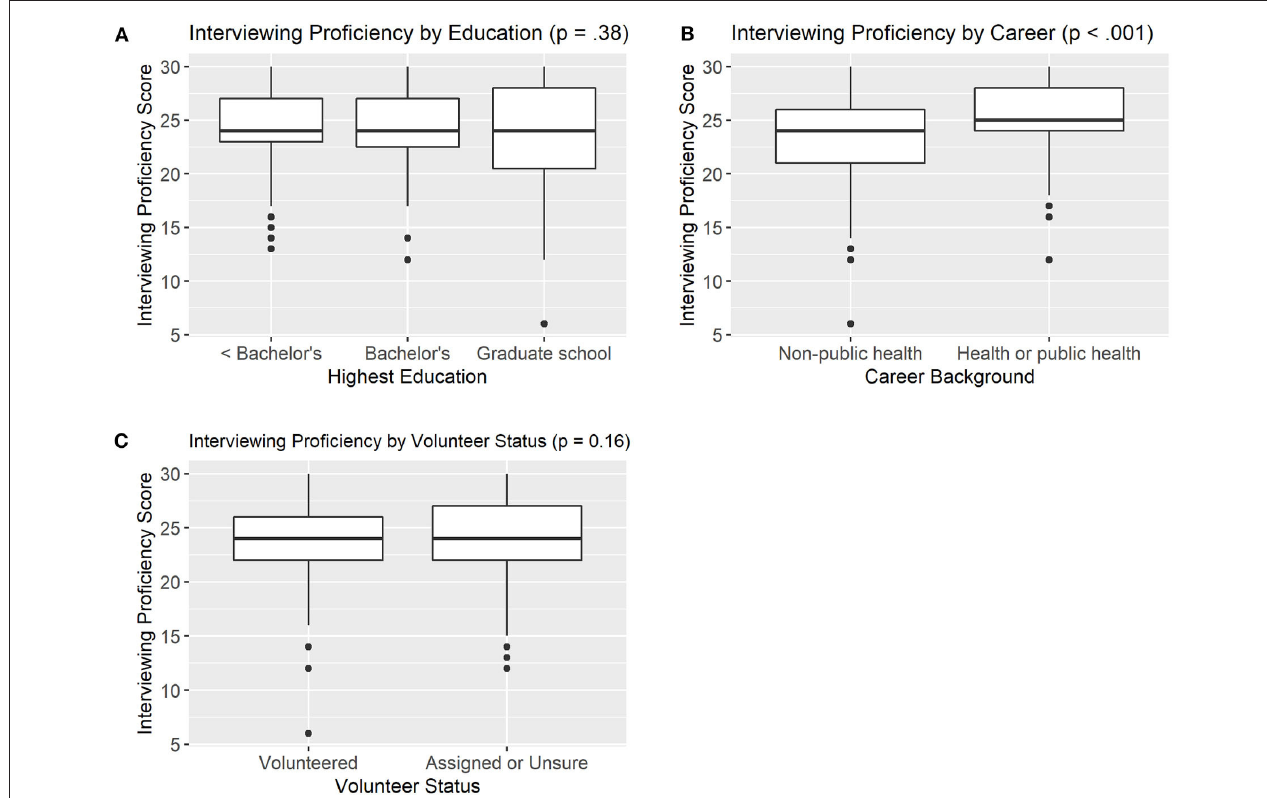
FIGURE 1 | Differences in Self-Perceived Interviewing Proficiency by Education Level ( A , n = 383), Career Background ( B , n = 353), and Volunteer Status ( C , n =